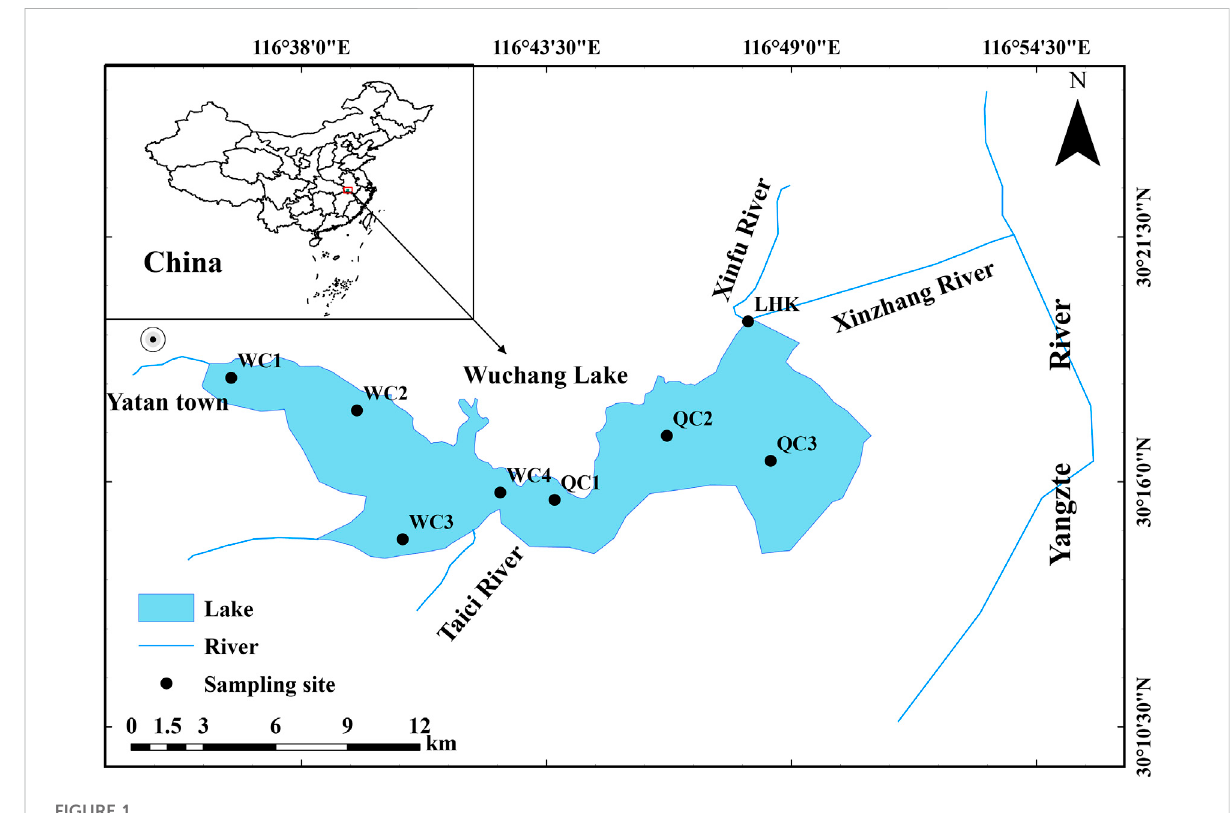
FIGURE 1 Distribution of sampling site in Lake